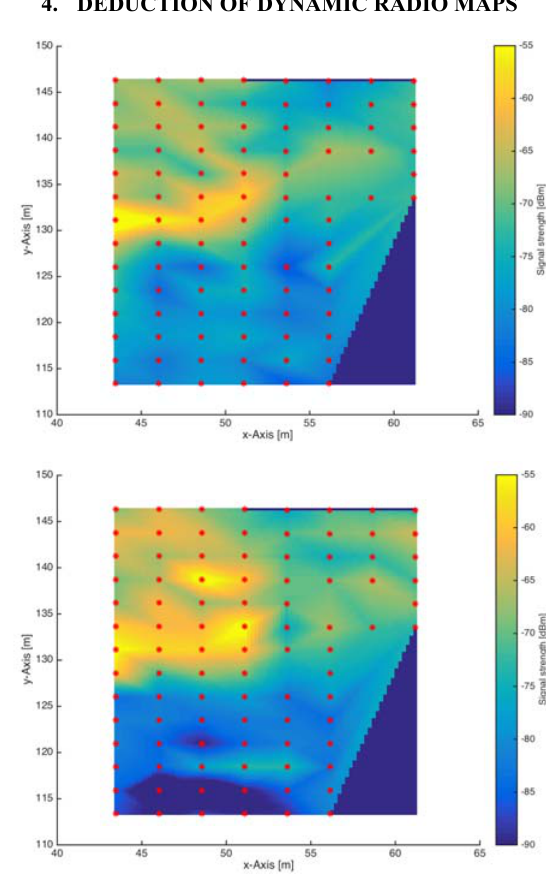
Figure 8. Example of radio maps of AP